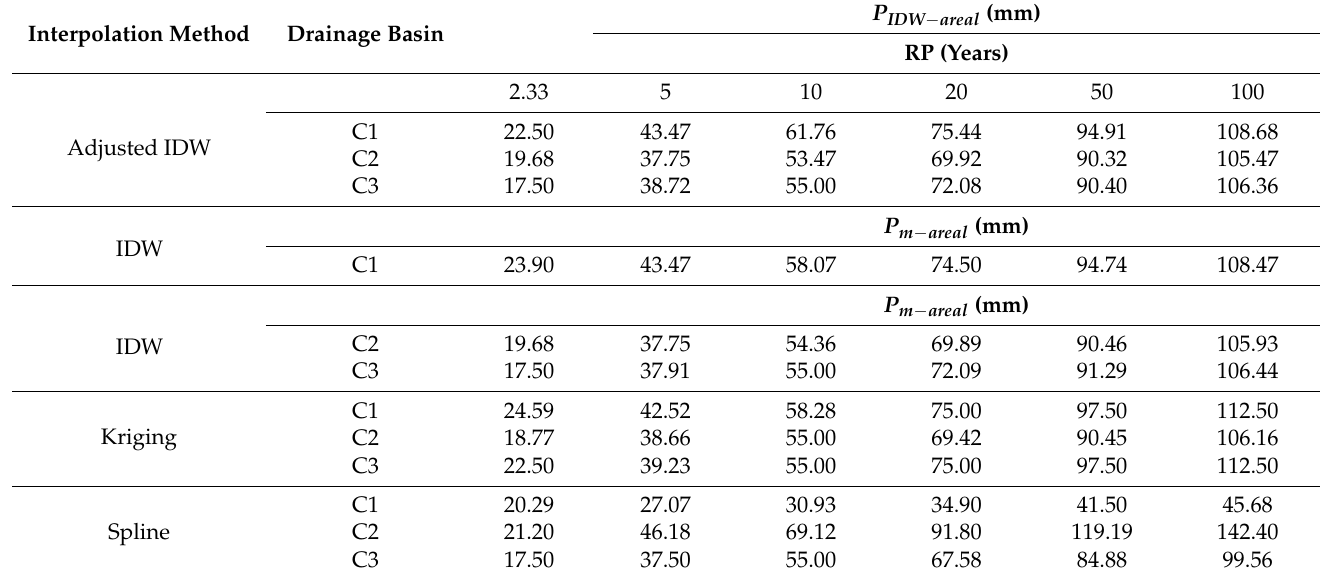
Table 6. Values of PIDW-areal and Pm-areal for the different interpolation methods.